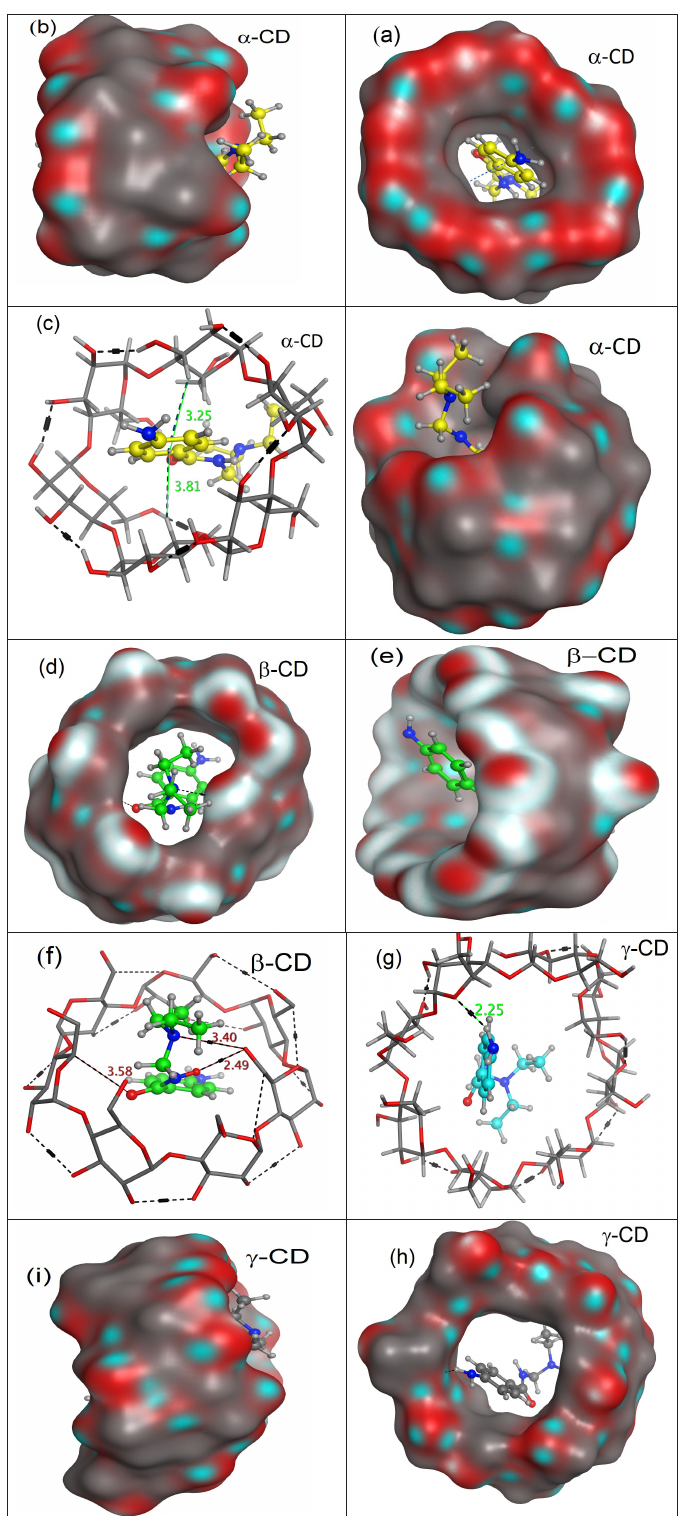
Figure 5: The predicted orientations and binding interactions of procainamide within the cavity of three cyclodextrins (a) α -CD, (b) β -CD, and (c) γ -CD from the table view of the wide edge (a, d, and h), side view (b. e and i), and as stick molecular depiction (c, f and g). Hydrogen bonds and hydrophobic interactions are demonstrated as magenta and green dashed lines,